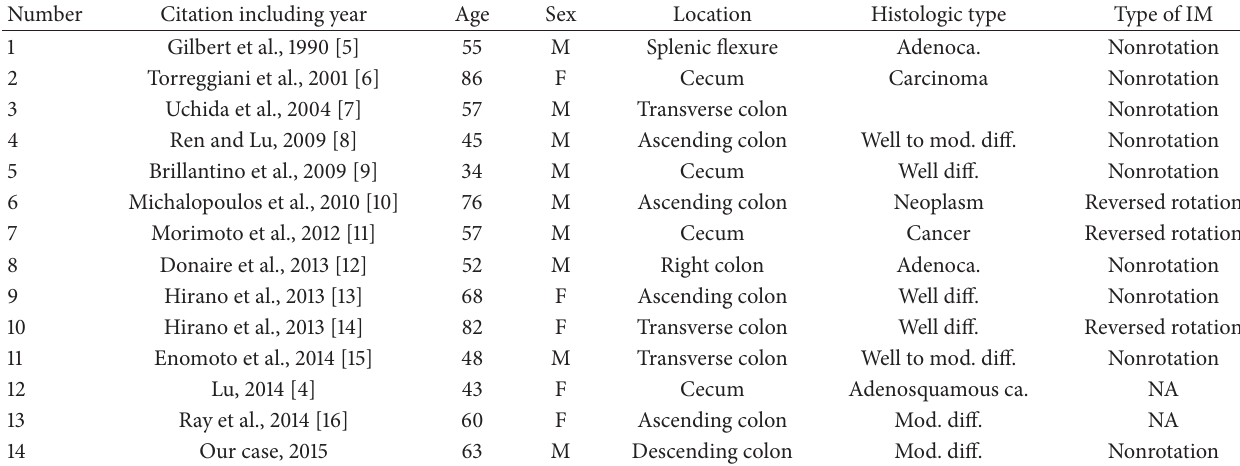
Table 1: Case reports of colon cancer in adult patient with intestinal malrotation in English literature, which except the coexistent cases with situs inversus